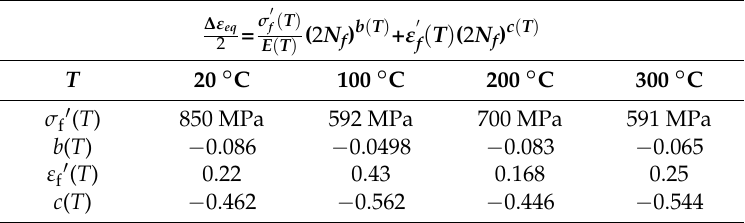
Table 3. Coefficients and factors of the fatigue curve for the EN AW-2024T3 alloy at different temperature values